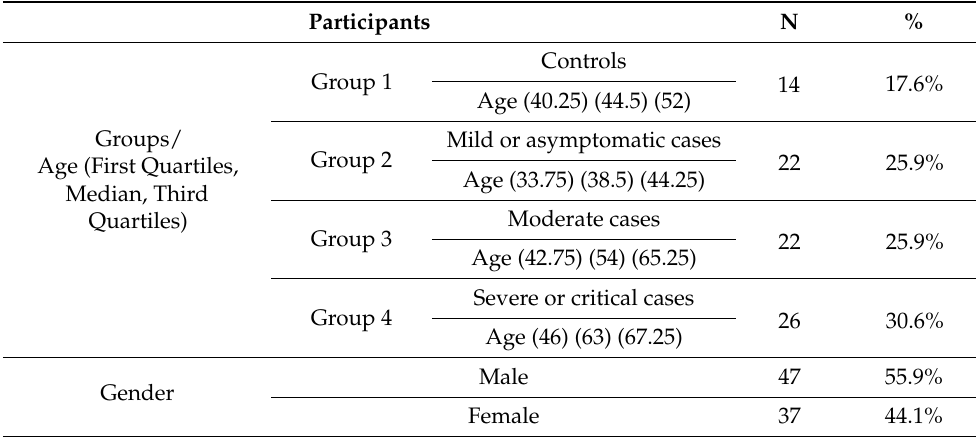
Table 1. Study group distribution and participants’ demographic data.